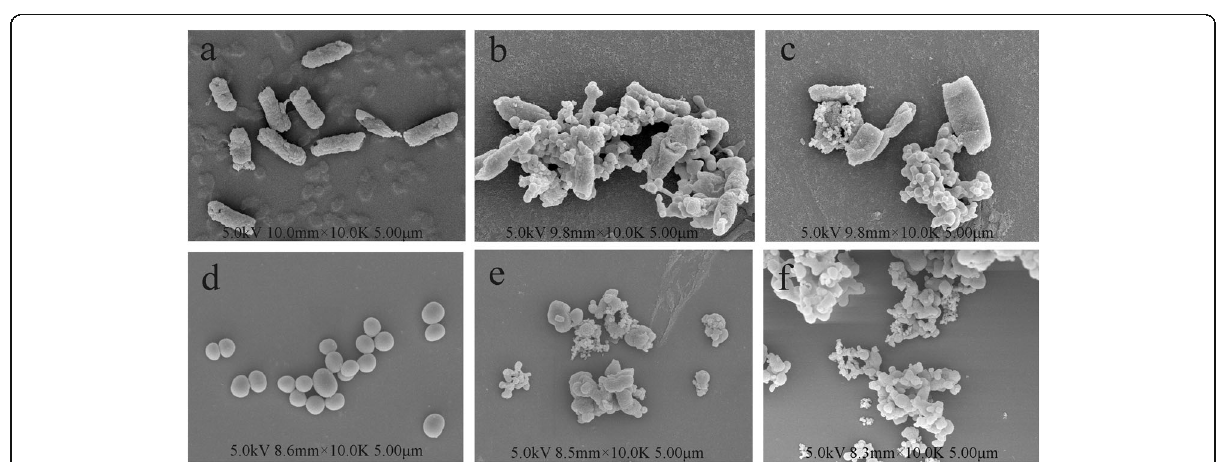
Fig. 6 Metamorphic structure of S. paratyphi A and S. aureus treated with VEE and VBF. Note: a : normal S. paratyphi A; b : S. paratyphi A treated by VEE; c : S. paratyphi A treated by VBF; d : normal S. aureus ; e : S. aureus treated by VEE; f : S. aureus treated by